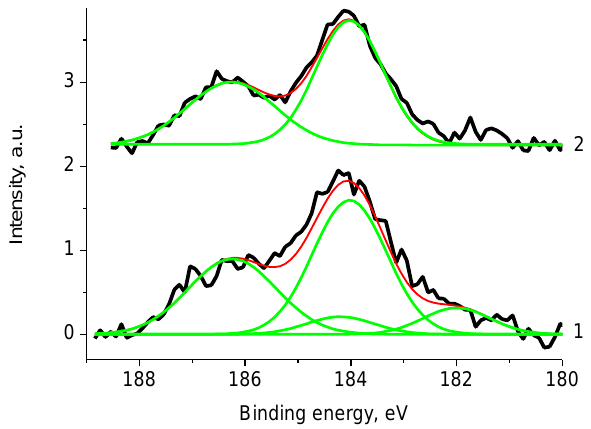
Figure 25. The Zr 3d photoelectron spectra of sample Pt/1′ measured with Mg (1) and Al (2) anodes (initial spectra – black, basic curves – green, resulting curves – red).